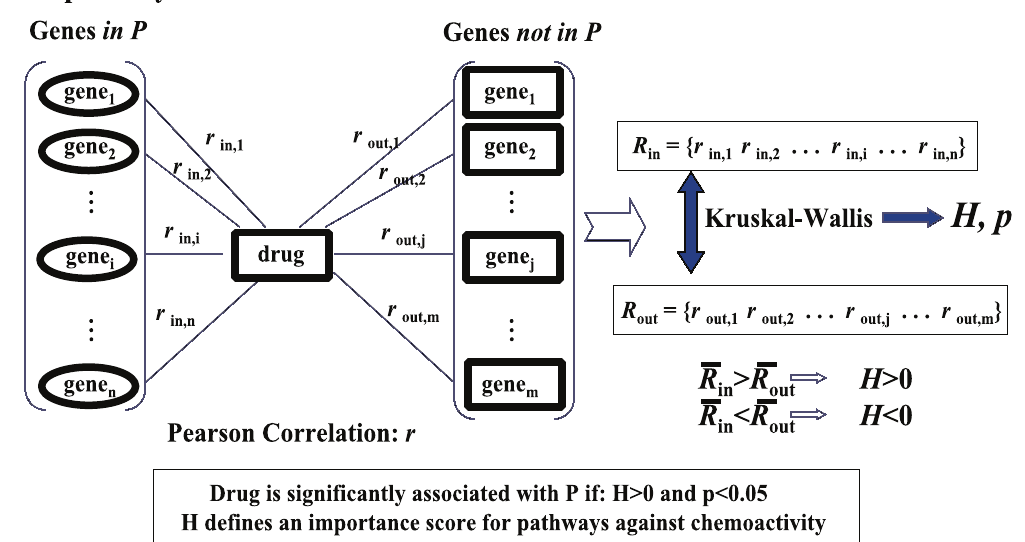
Figure 1. Schematic for calculating H-scores. For each pathway, P, select genes in P (ovals at left) and not in P (squares in middle). Calculate a Pearson correlation coefficient between all gene expressions and each SOM GI50 profile (designated as ‘drug’ in the central square). Use a Kruskal- Wallis(K-W) statistic to determine if the rankings of the pathway genes (ovals at left) versus non-pathway genes (squares in the middle) are significantly skewed towards extreme values. The H-score for each pathway is derived from the K-W statistic. Cases where the average of correlations associated with pathway genes is greater than the average of correlations for non-pathway genes characterize positive H-scores. Positive and significant (p , 0.05) H-scores reflect pathways with coordinated (as opposed to random) gene expression-chemoactivity correlations. H-scores for each pathway (n=2160) are determined for all SOM GI50 profiles (n=1998).